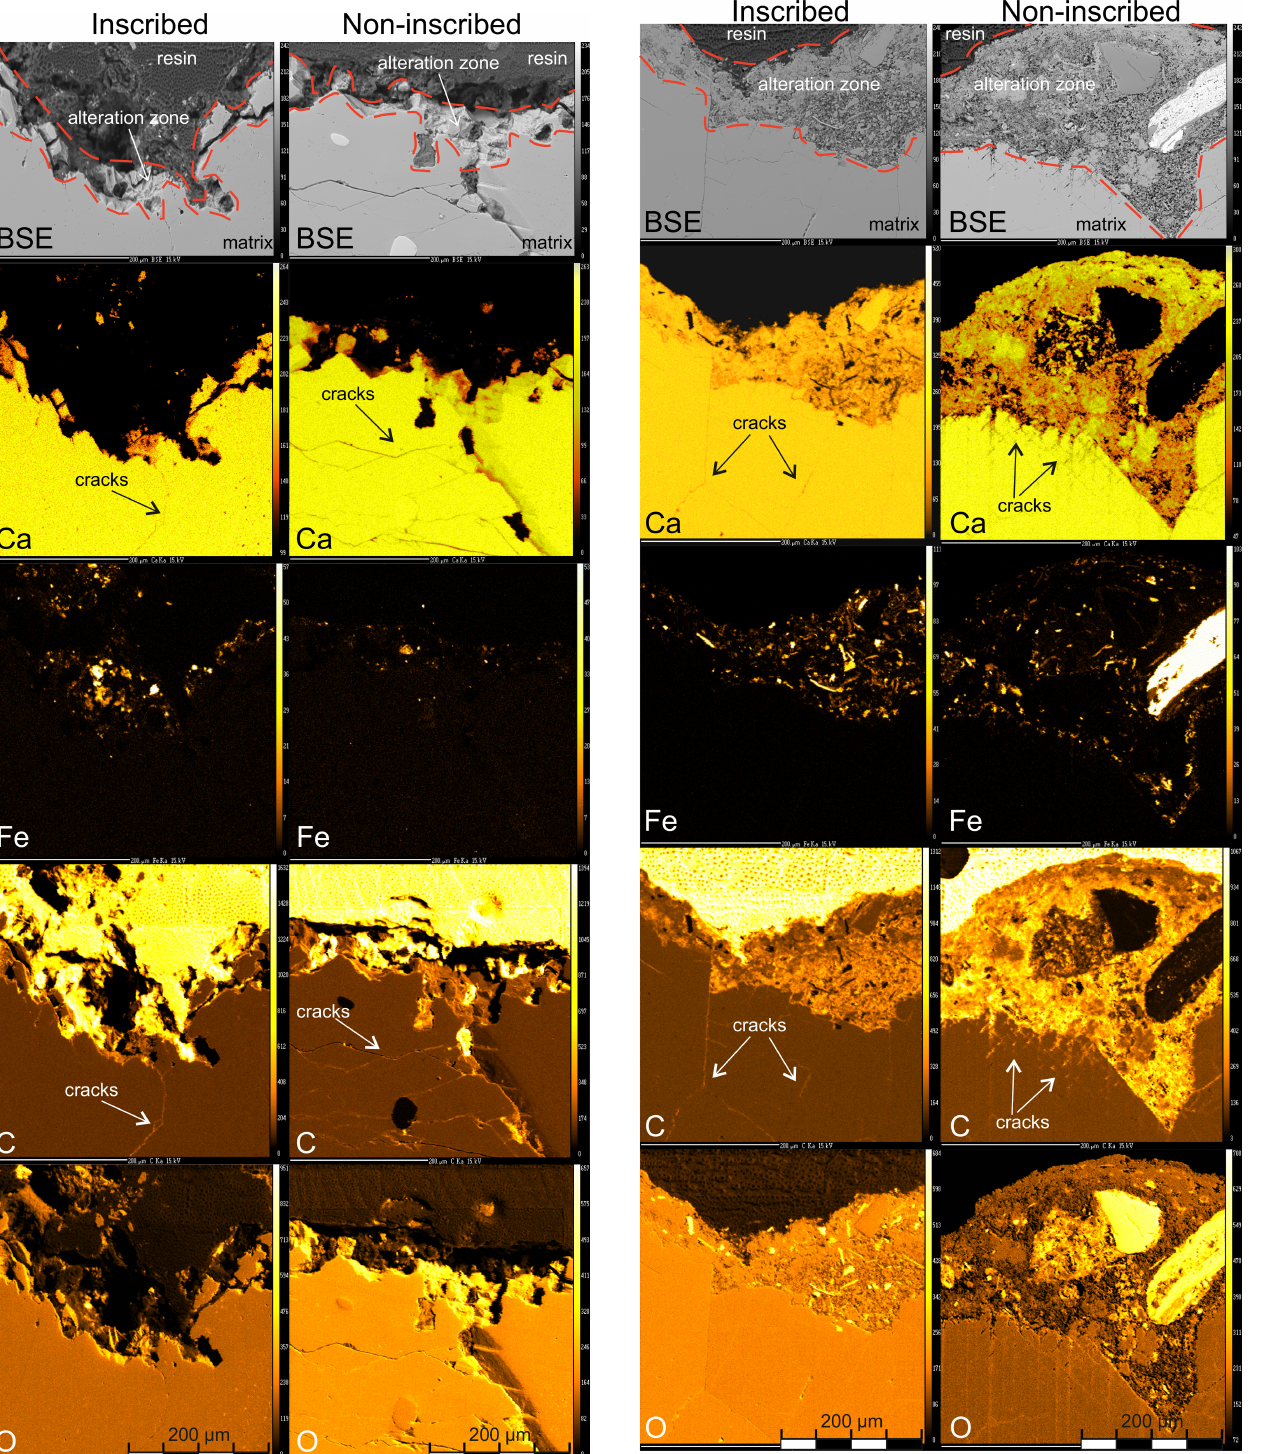
Figure 4. Backscattered electron (BSE) image and maps of selected elements of a polished cross section of sample MaD1B (Hamburg) beneath and away from engraved letters. Dashed lines trace the al- tered surface layer.